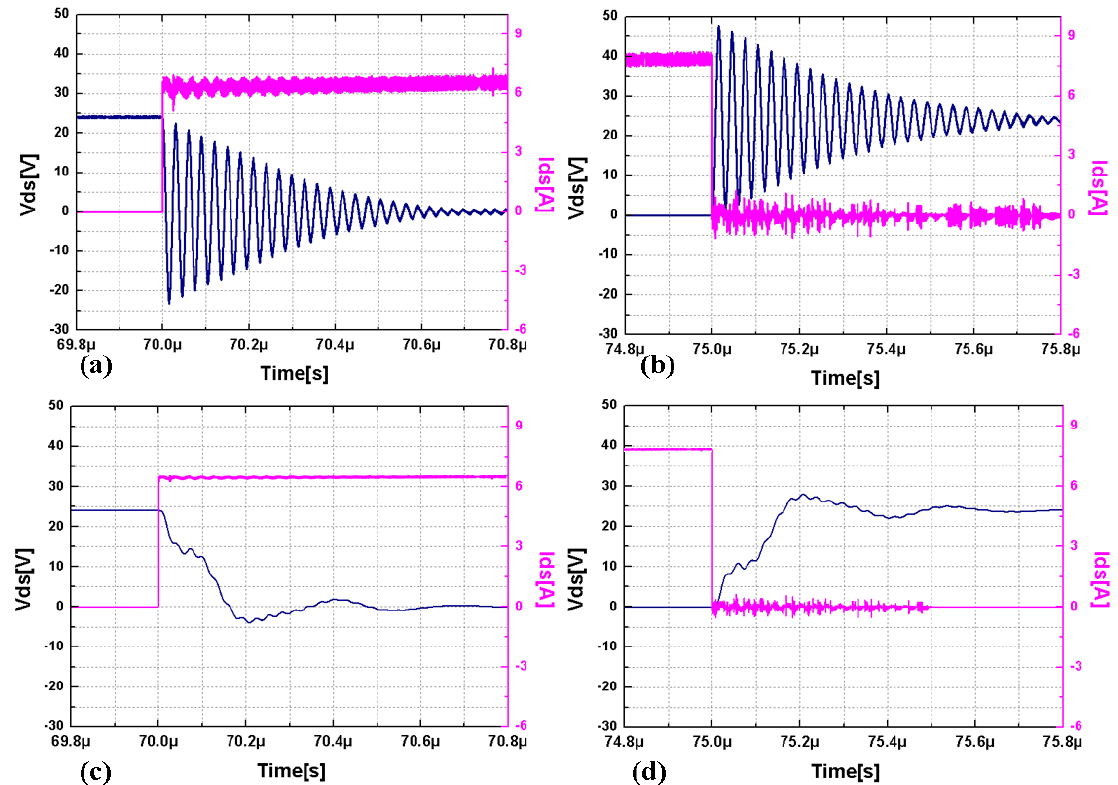
Figure 17. The comparison of switching waveform before and after applying the proposed method. ( a ) The voltage and current switching waveforms at turn-on before method applied; ( b ) The voltage and current switching waveforms at turn-off before method applied; ( c) The voltage and current switching waveforms at turn-on after method applied; ( d ) The voltage and current switching waveforms at turn-off after method applied.